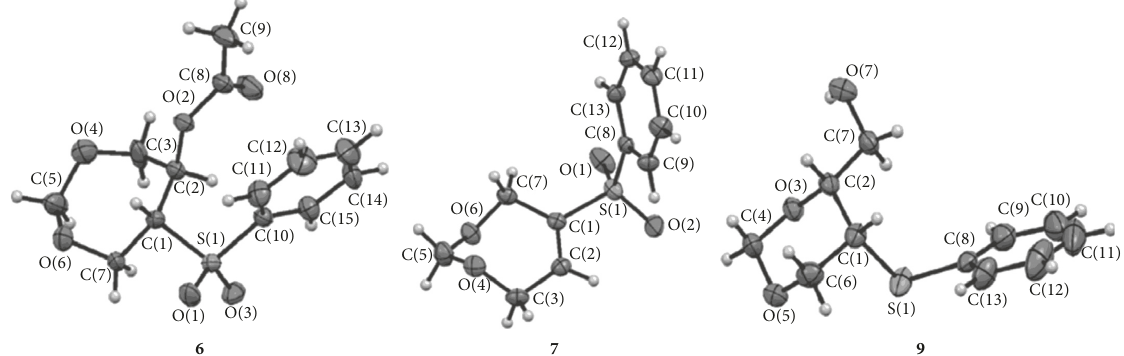
Figure 1: The geometry of compounds 6 , 7 , and 9 according to X-ray structural analysis.